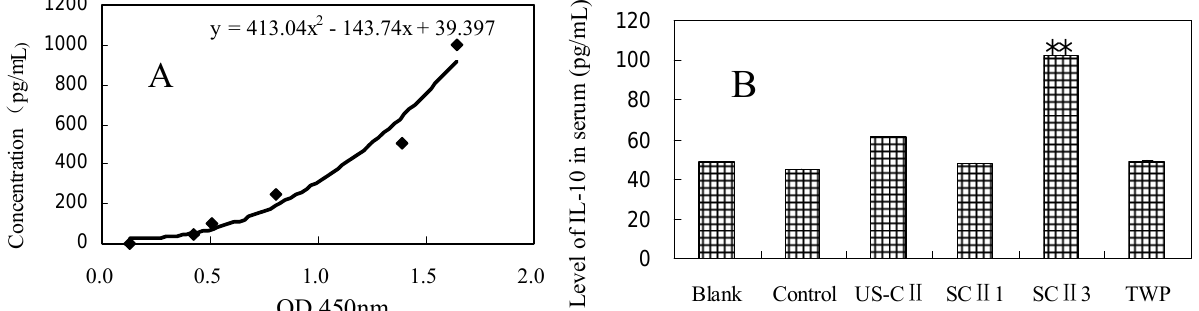
Figure 4. Effects of drugs on the expression of IL-10 in CFA rats (n = 10). ( A ) standard curve for the relationship between the concentrations of IL-10 and the absorbance at 450 nm; ( B ) the average level of IL-10 in serum of each experiment